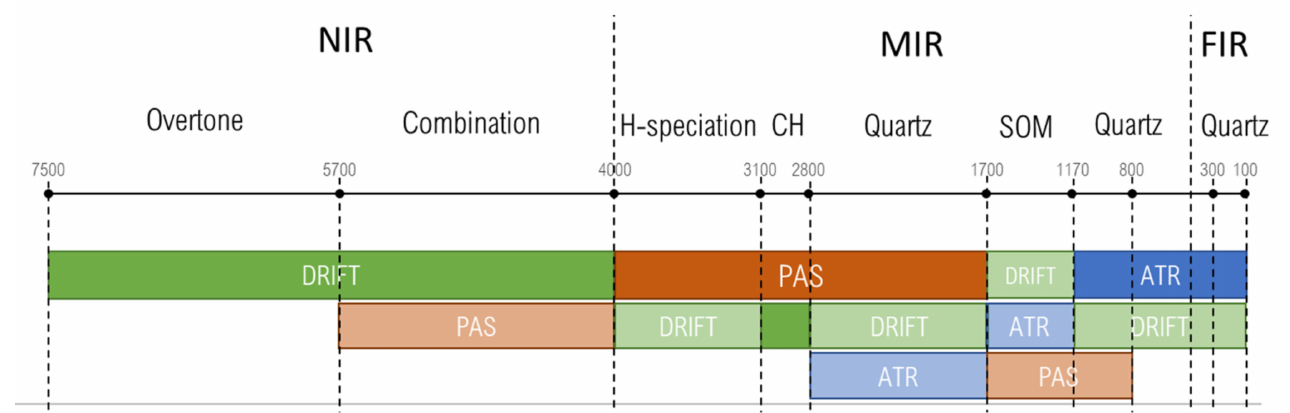
Figure 12. Applicability of DRIFT, ATR–FTIR, and FTIR–PAS for qualitative soil analysis for silicate soils. Applicable techniques are shown in full colors, ambiguous, in watercolors, most informative technique in each subregion (see the text for details) is shown at a higher